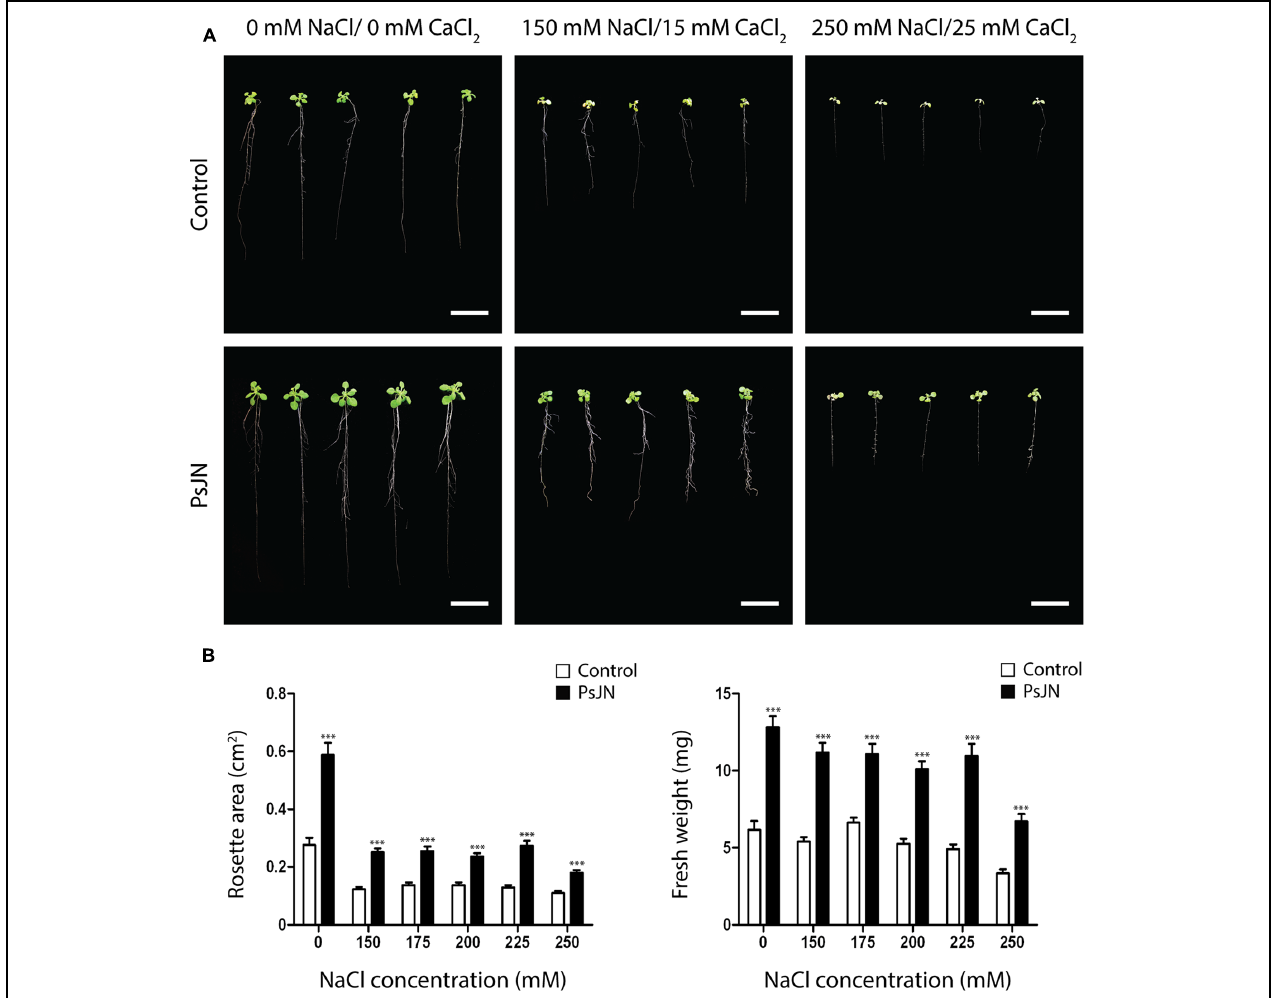
FIGURE 1 | Effects of Burkholderia phytofirmans PsJN on Arabidopsis thaliana growth in vitro . (A) Representative photographs of A. thaliana plants treated with or without B. phytofirmans PsJN, and transplanted at 11 days after sowing (DAS) to Murashige Skoog (MS) with or without addition of salt (150 mM NaCl/15 mM CaCl 2 to 250 mM NaCl/25 mM CaCl 2 ). Data was collected 7 days after transplantation. (B) Graphic